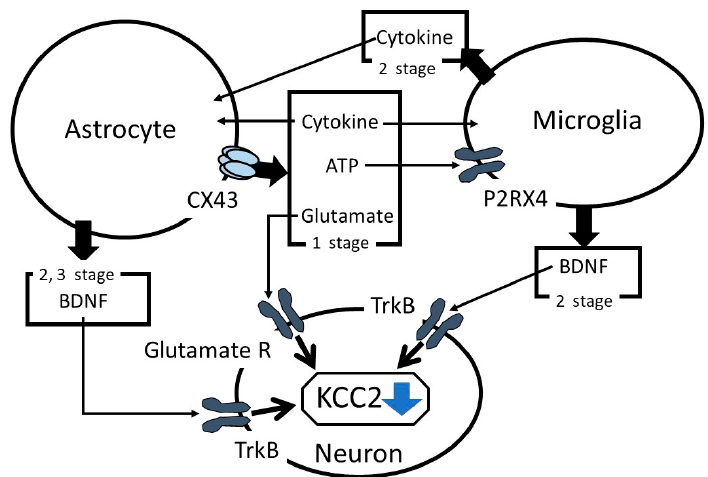
Figure 1. Summary of the role of astrocytes in the alterations of K + -Cl − -cotransporter-2 (KCC2) functions. TrkB: tropomyosin receptor kinase B and BDNF: brain-derived neurotrophic factor.